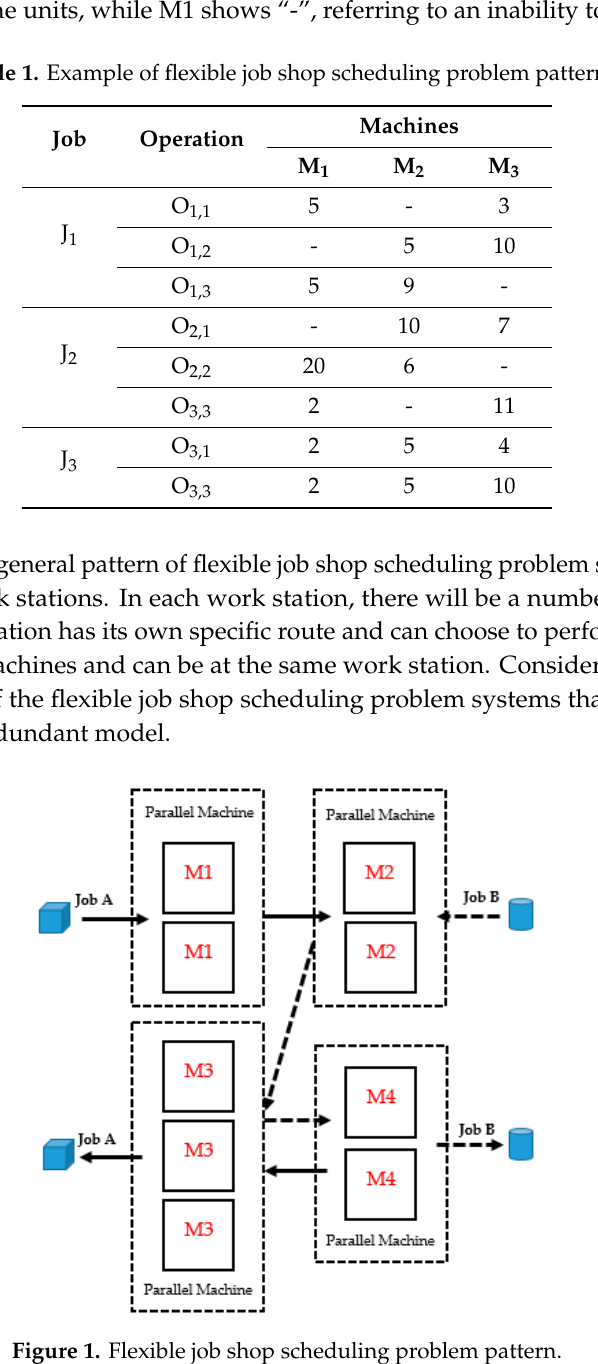
Table 1. Example of flexible job shop scheduling problem pattern.